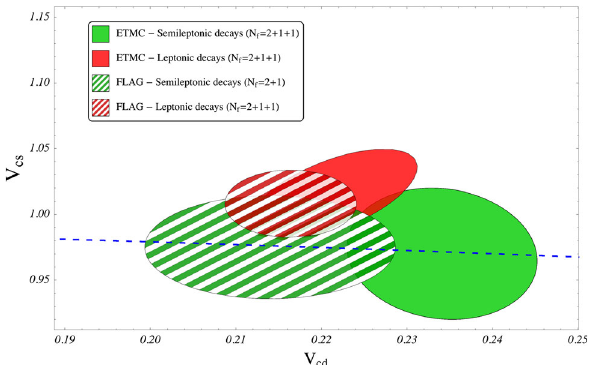
Fig. 2 Results for | V cd | and | V cs | obtained from leptonic D - and D s - meson and semileptonic D -meson decays, represented respectively by red and green ellipses corresponding to a 68% probability contour. The solid ellipses are the results of Ref. [21] and of this work, obtained with N f = 2 + 1 + 1 dynamical quarks. The correlations between | V cd | and | V cs | are properly taken into account (see text). The striped ellipses correspond to the latest FLAG results [3], which for the semileptonic decays are based on the LQCD results obtained in Refs. [22,23] with N f = 2 + 1 dynamical quarks. The dashed line indicates the correlation between | V cd | and | V cs | that follows from the CKM